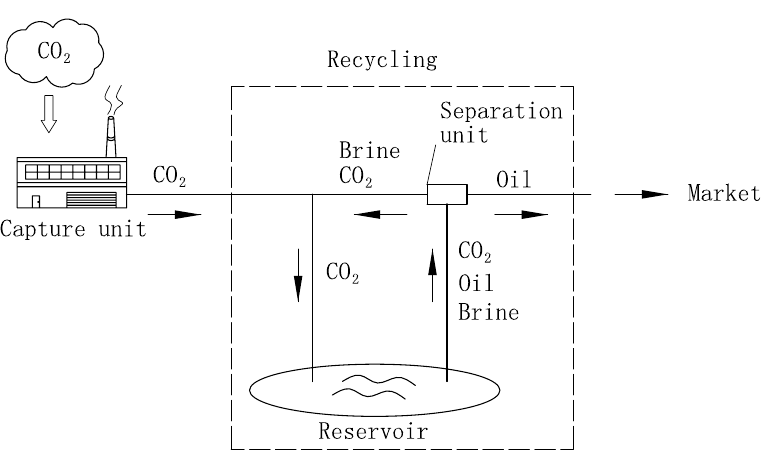
-EOR system flow 2